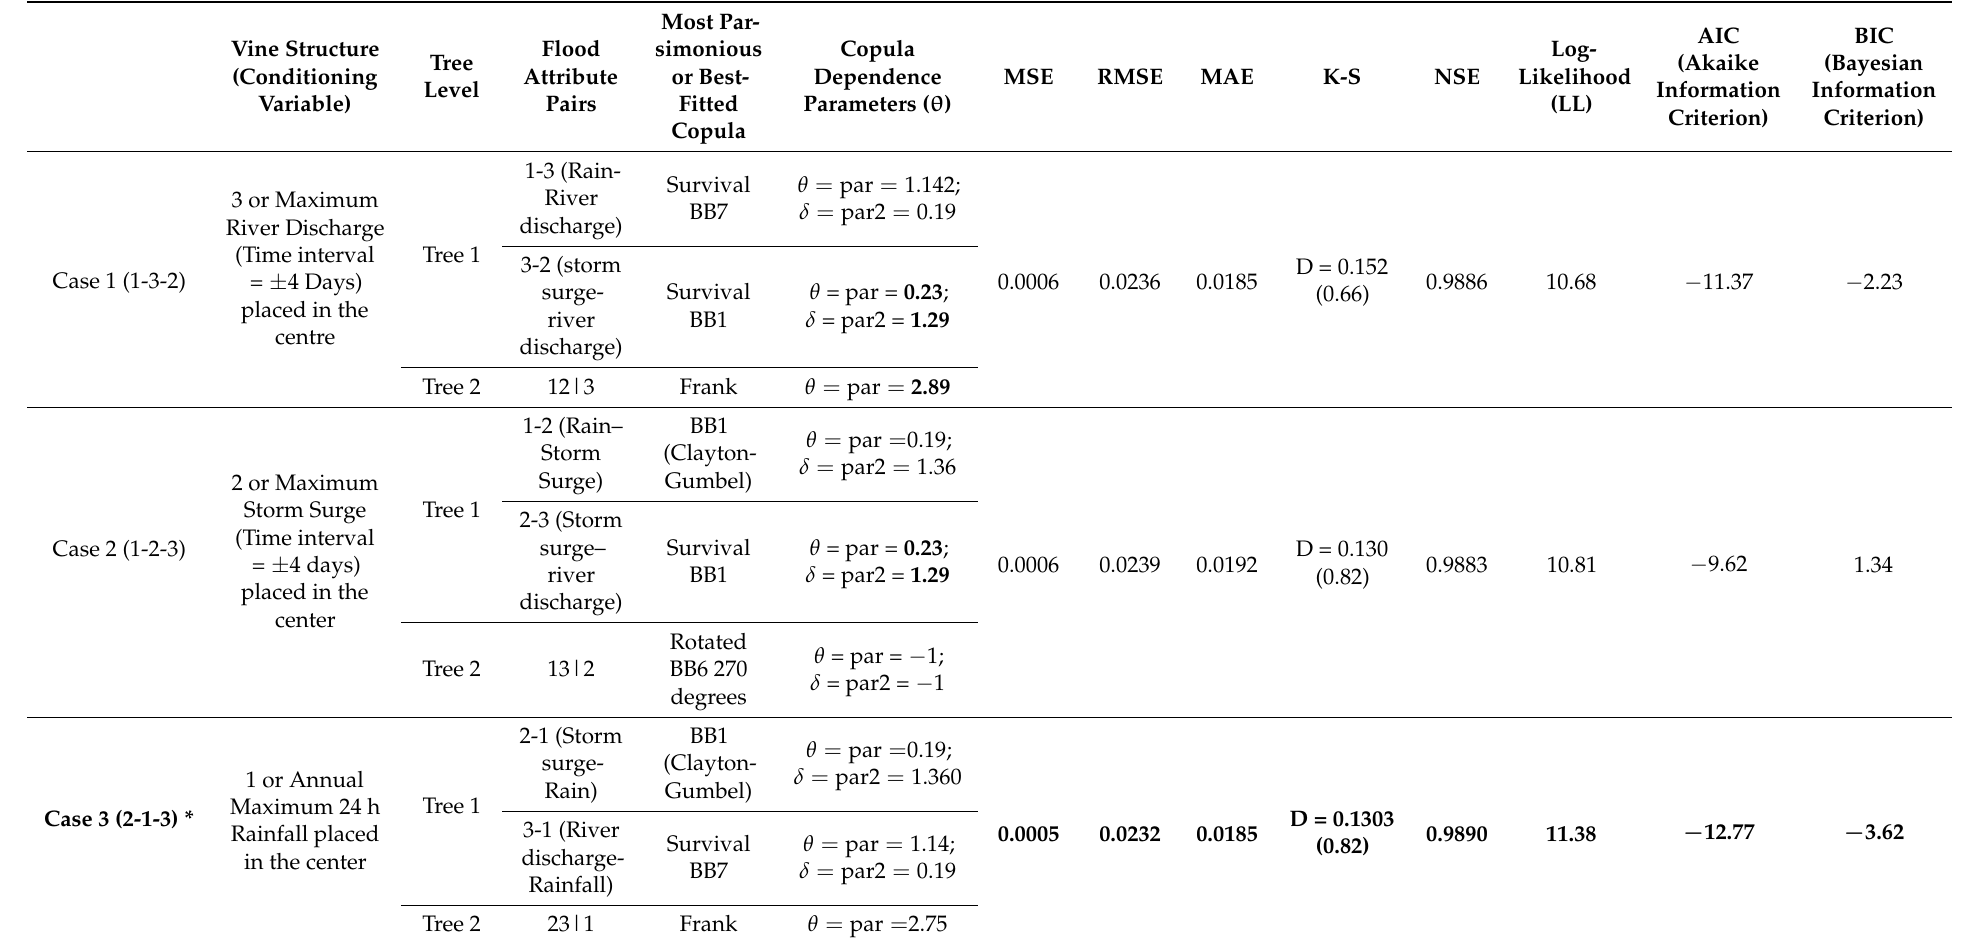
Table 6. Details of the fitted 3-D vine structure in the semiparametric distribution settings for three different